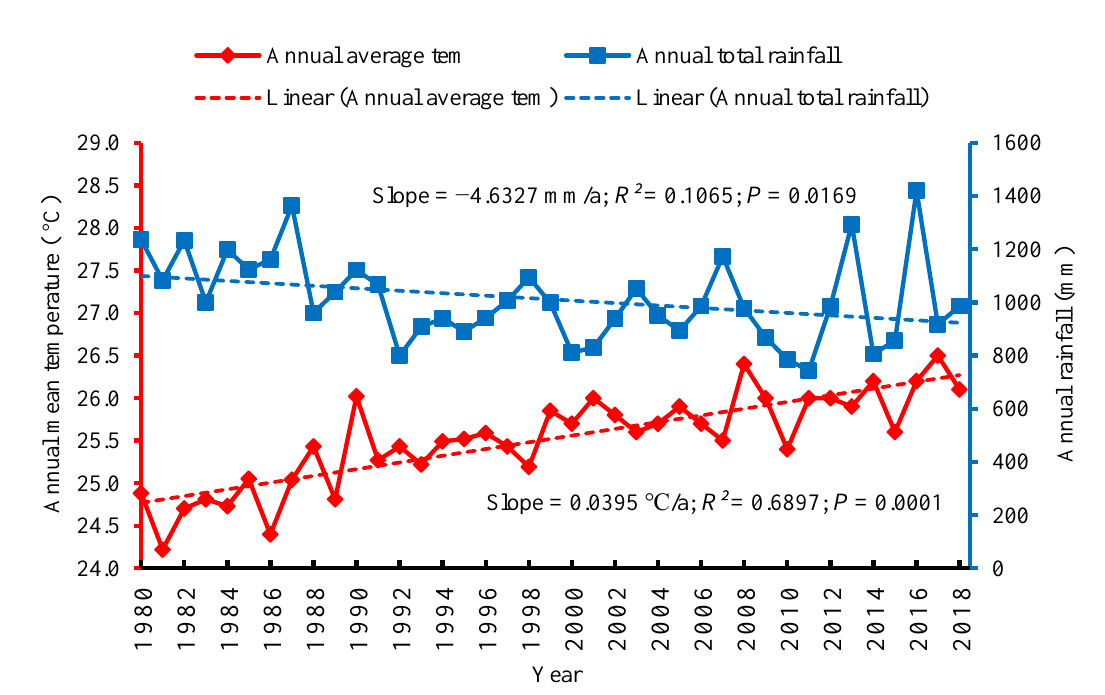
Figure 5. Climatic trend in the Gangetic plain of the trans-boundary KRB.